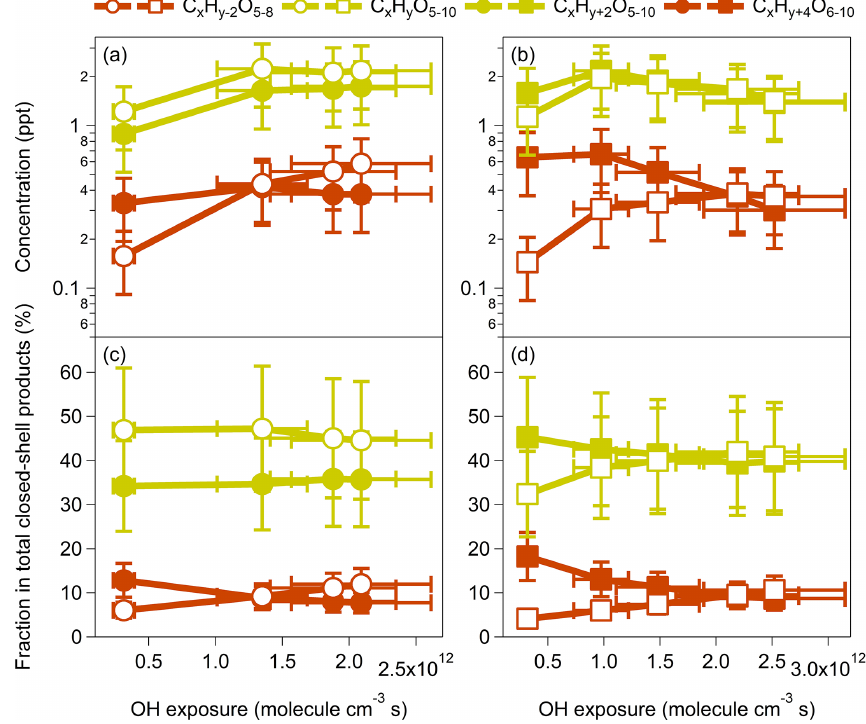
Figure 3. Concentrations and relative contributions of closed-shell monomeric products formed by benzene and toluene oxidation under low-NO x conditions (OFR254-5) at various OH exposures. For the benzene oxidation, both x and y are 6. For the toluene oxidation, x is 7, and y is